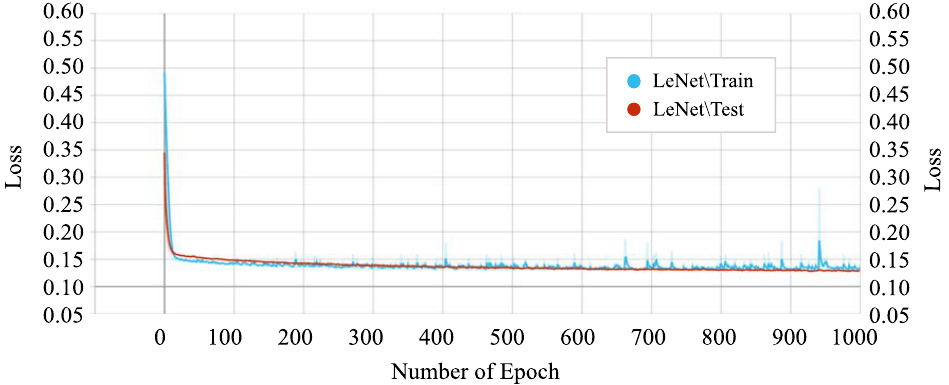
Figure 14. Training and testing loss of the proposed P-LeNet